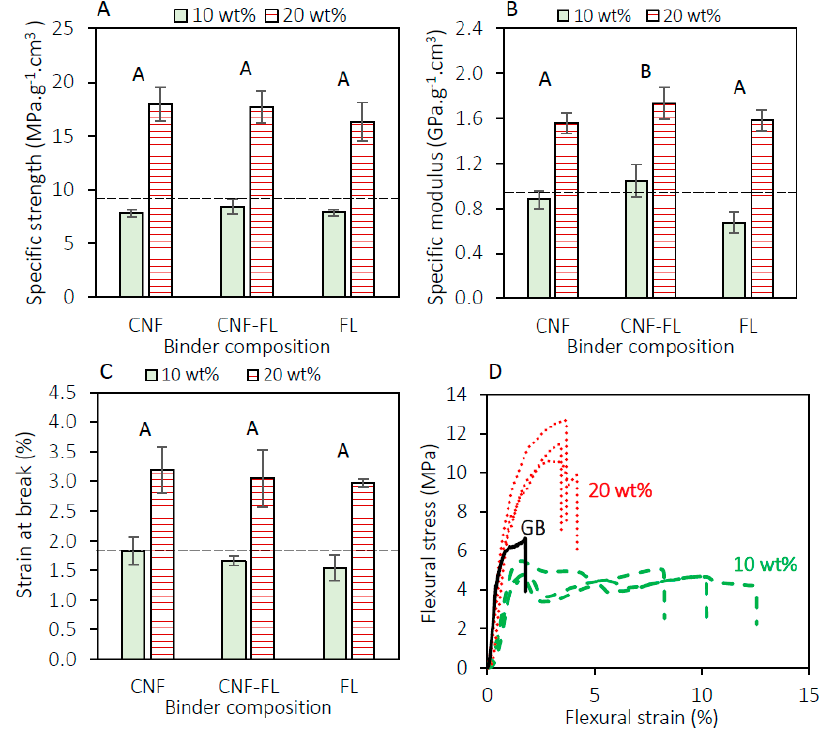
Figure 4. Effect of binder dosage and binder type on ( A ) specific strength, ( B ) specific modulus, ( C ) strain at break, and ( D ) stress vs. strain curve. The dashed horizontal line shows the corresponding value of commercial gypsum board. Columns with common letters are not statistically different at the 95% confidence level. (FL: FiberLean TM ).